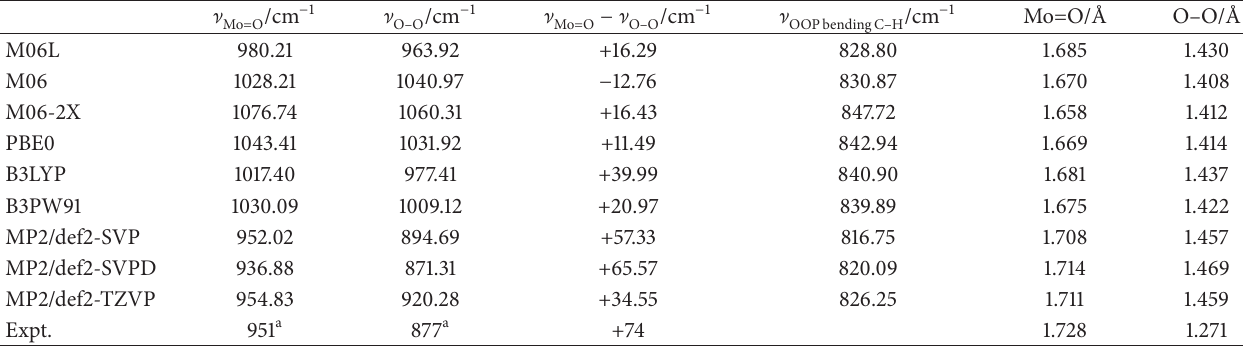
Table 4: Mo=O and O–O stretching, and Cp’s C–H OOP bending frequencies for 1 .